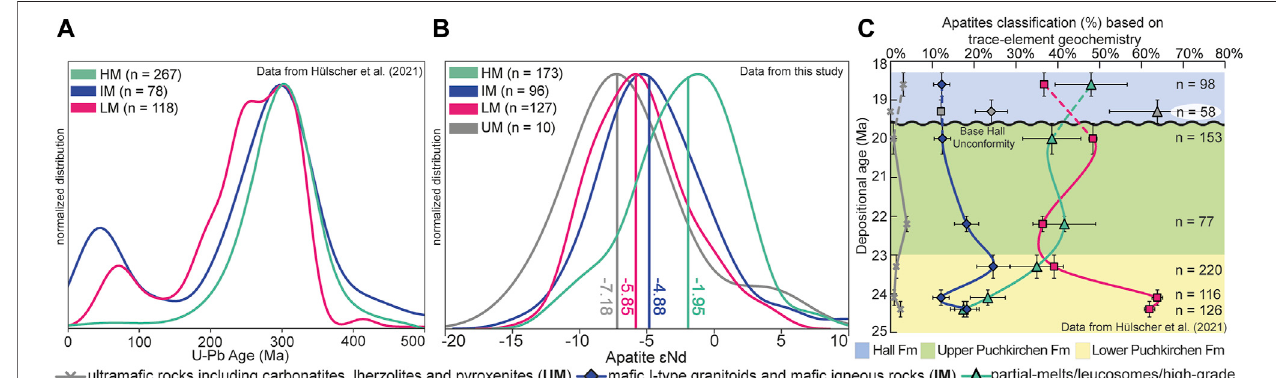
FIGURE 5 | Sand-sized apatite single-grain analyses. (A) Kernel density estimation plot of the U-Pb ages of the detrital apatites separated based on their trace- elementgeochemistryandthediscriminationdiagramofO ’ Sullivanetal.(2020).AllapatitegroupsshowastronglateVariscan/earlyPermian(250 – 350 Ma)peak.TheIM and LM grains also show Mesozoic, Eoalpine and Alpine ages. (B) Distribution of the apatite ε Nd values of the individual apatite groups. Vertical bars represent the median of the distributions. Note the signi fi cantly higher ε Nd values in the HM apatites. (C) Evolution of apatite characterization plotted against the depositional ages. TheshareofHMapatitesincreasefrom~20%to~40%at23.3 Ma.Apatitesamplesbetween19.6and19.0 Maareexcludedfromthetrendbecause fi ssiontrack andforaminiferalanalysisindicatethatthesesamplescontainrecycledsediment(Grunertetal.,2013;Hülscheretal.,2021).Uncertaintiesarebasedontheuncertainties ofthedepositionalagesandtheprobabilityofpossibleapatitemisclassi fi cationbasedonthediscriminationsuccessrate(O ’ Sullivanetal.,2020). n =numberofanalyzed apatites. Data of (A) and (C) from Hülscher et al. (2021), data of (B) is presented in this study. The apatites from S-type granitoids and HM sources, as differentiated by O ’ Sullivan et al. (2020), are grouped as HM apatites for